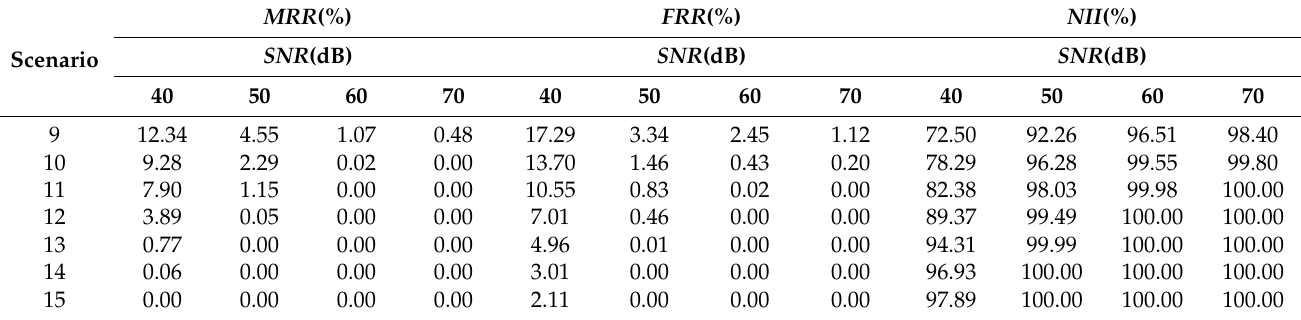
Table 4. SEW WPNE noise resistance analysis